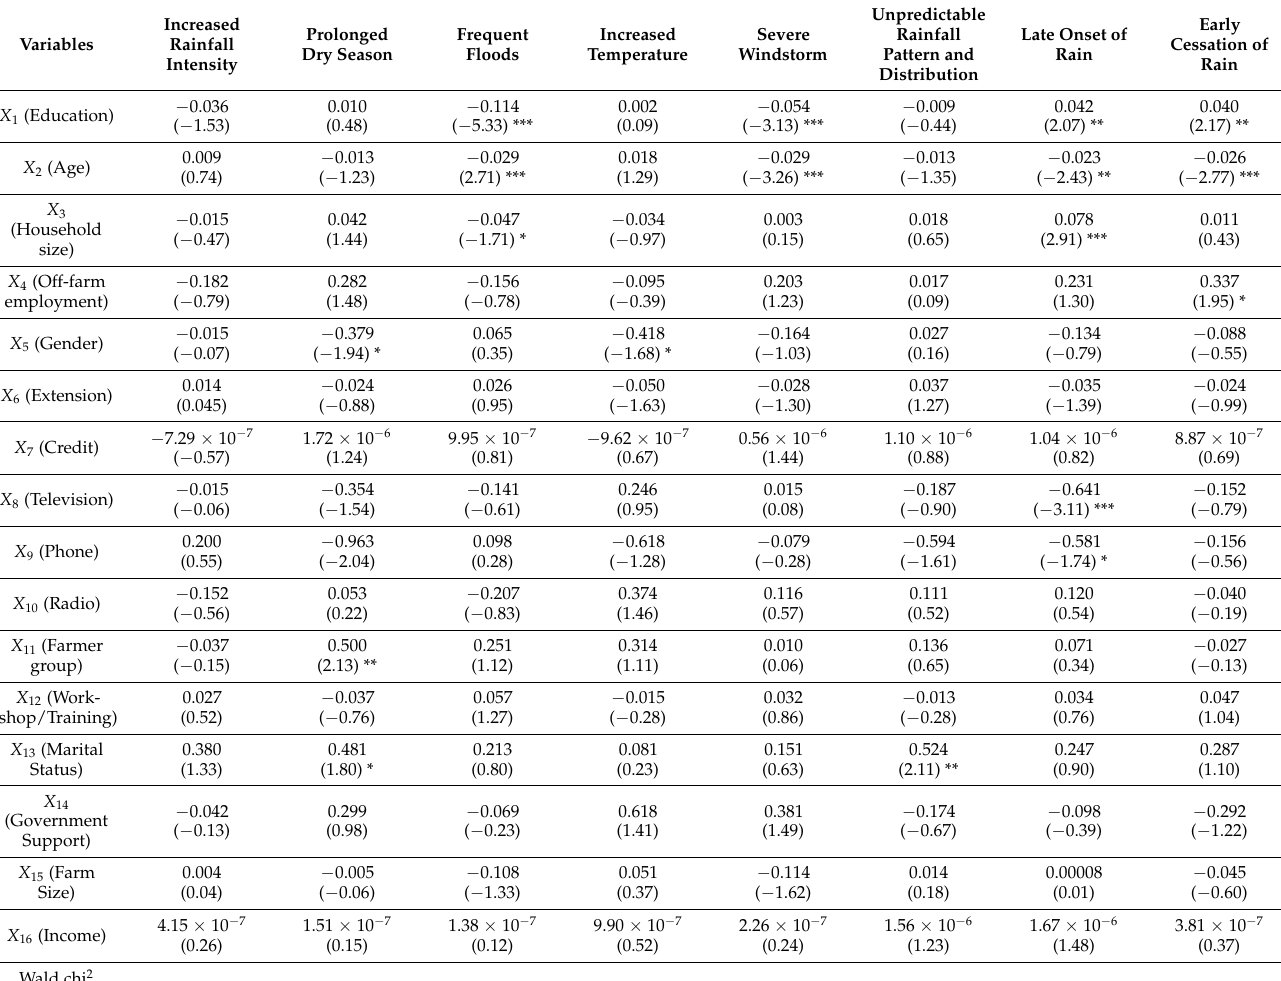
Table 2. Multivariate probit regression result of determinants of farmers’ perception of climate